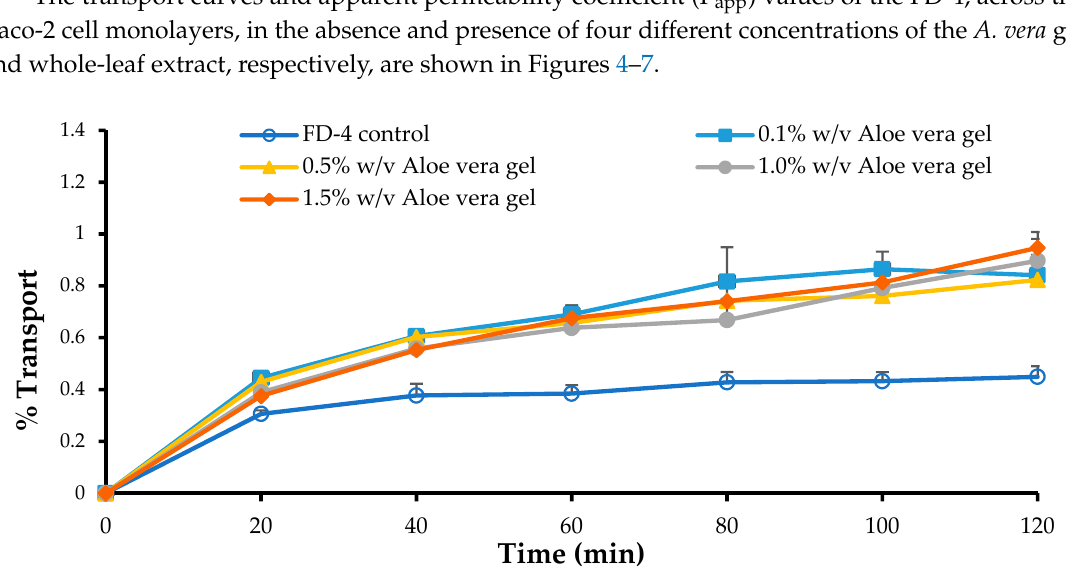
Figure 5. Apparent permeability coefficient (P app ) values of the FITC-dextran (FD-4 with MW of 4 kDa), across the Caco-2 cell monolayers, when co-applied with the Aloe vera gel solutions. Bars marked with an asterisk (*) indicate statistical significant differences from the control ( p < 0.05) ( n = 3; error bars represent SD) (R = permeation-enhancement ratio). A slightly higher than the two-fold increase in the transport of the FD-4 (R or permeation- enhancement ratio values indicated on Figure 5) in relation to the control group (FD-4 alone) was shown for all the concentrations of the A. vera gel solutions tested. The transport of the FD-4 was, statistically, significantly higher ( p < 0.05) in the presence of all the A. vera gel solutions, compared to the transport of the control group (FD-4 alone). A. vera gel, therefore, showed the ability to significantly enhance the transport of a macromolecule (FD-4), across intestinal epithelial cell monolayers (Caco-2), which is in line with previous findings [32–34].